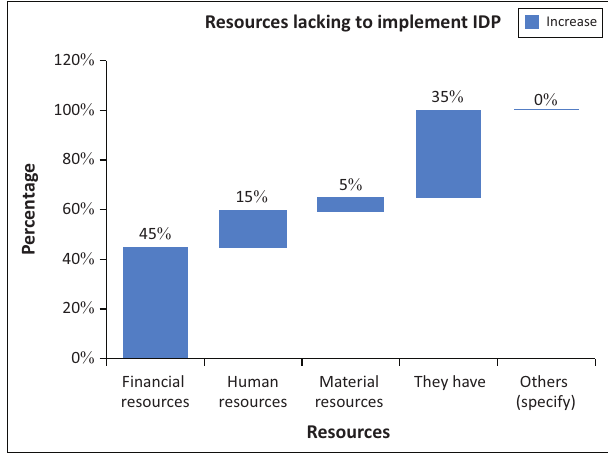
FIGURE 1: Municipal resources to implement integrated development plan